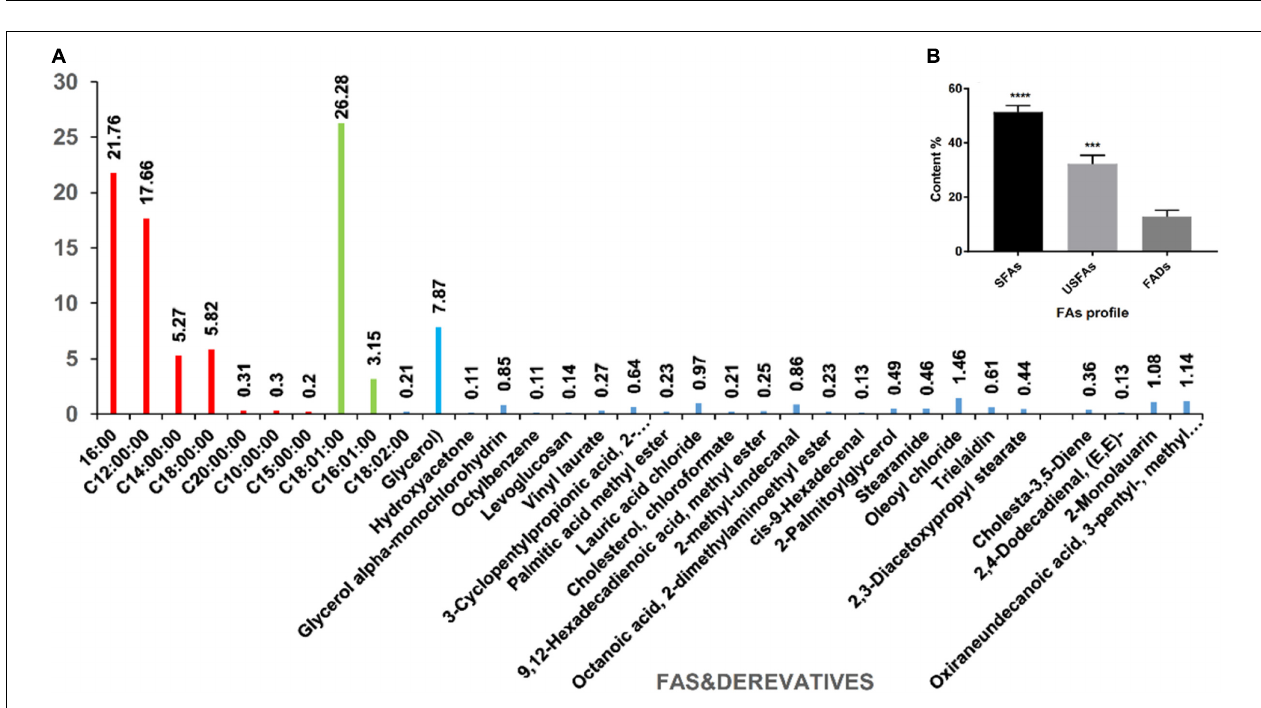
FIGURE 6 | Cytotoxicity of AWME3 fat on HEK-293 cell lines. Cells were treated with serial of AWME3 dilutions for 24 h. Then, viability of AWME3 treated-cells was measured using MTT assay (A,B) . Where, (A) cell lines were treated with AWME3 for 24 h (X-axis: log concentrations of AWME3 extract from 0 to 1,000 ( µ g/mL) and Y-axis: the percentage of normalized absorbance). (B) The of average OD 570 of the HEK-293 cell line treated with AWME3 for 24 h (Y-axis: the normalized absorbance of HEK-293 at OD 570 ), X-axis: AWME3 concentrations from 0 to 1,000 µ g/mL. The IC 50 values were calculated using the non-linear regression mode of Graph pad Prism7 (Graph Pad Software Inc., San Diego, CA, United States). All Results are the mean ( ± SEM) from three independent experiments performed in triplicates ( n = 8). Statistical values are indicated.